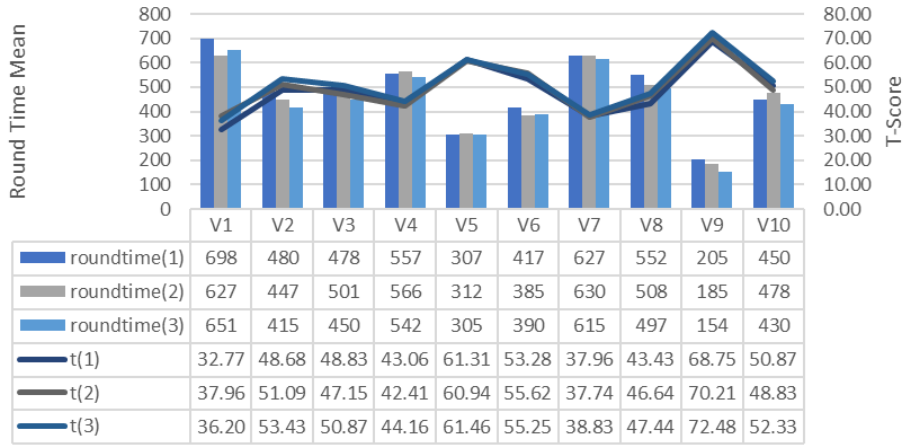
Figure 5. Relationship between GDES average track completion time and game performance (T- Score).